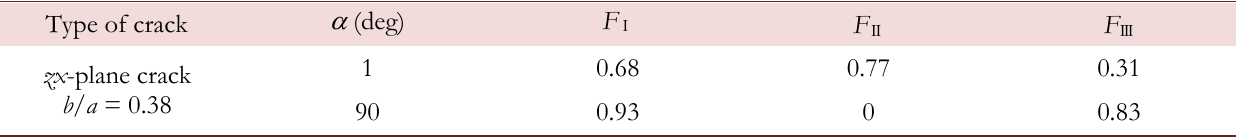
Table 1: Dimensionless stress intensity factors for the zx -plane crack ( b / a = 0.38, a = L /2).